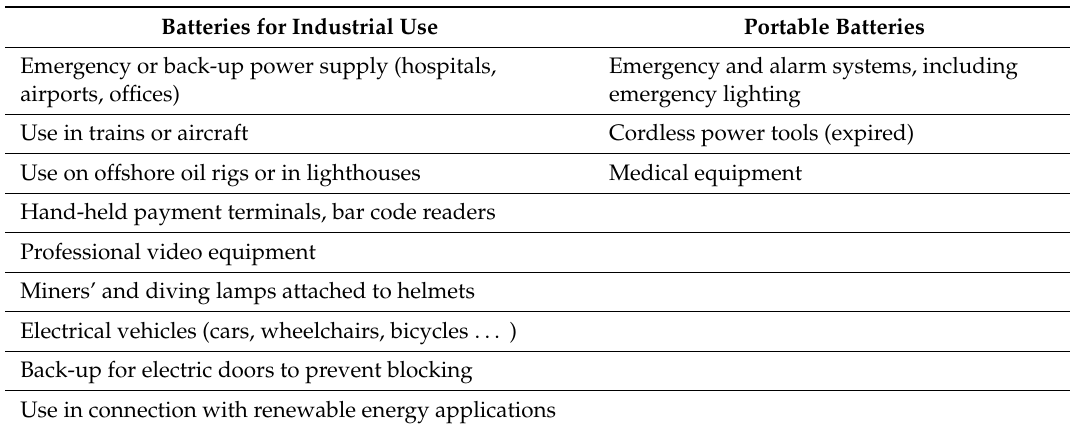
Table 1. Examples of “industrial” and “portable” NiCd accumulators; cf.